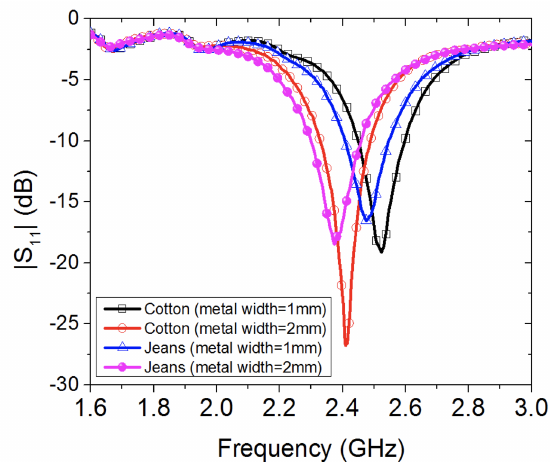
Figure 5. Measured reflection coefficient of the wearable loop antenna with two different fabrics: cotton and jeans, and two different metallic widths of 1 mm and 2